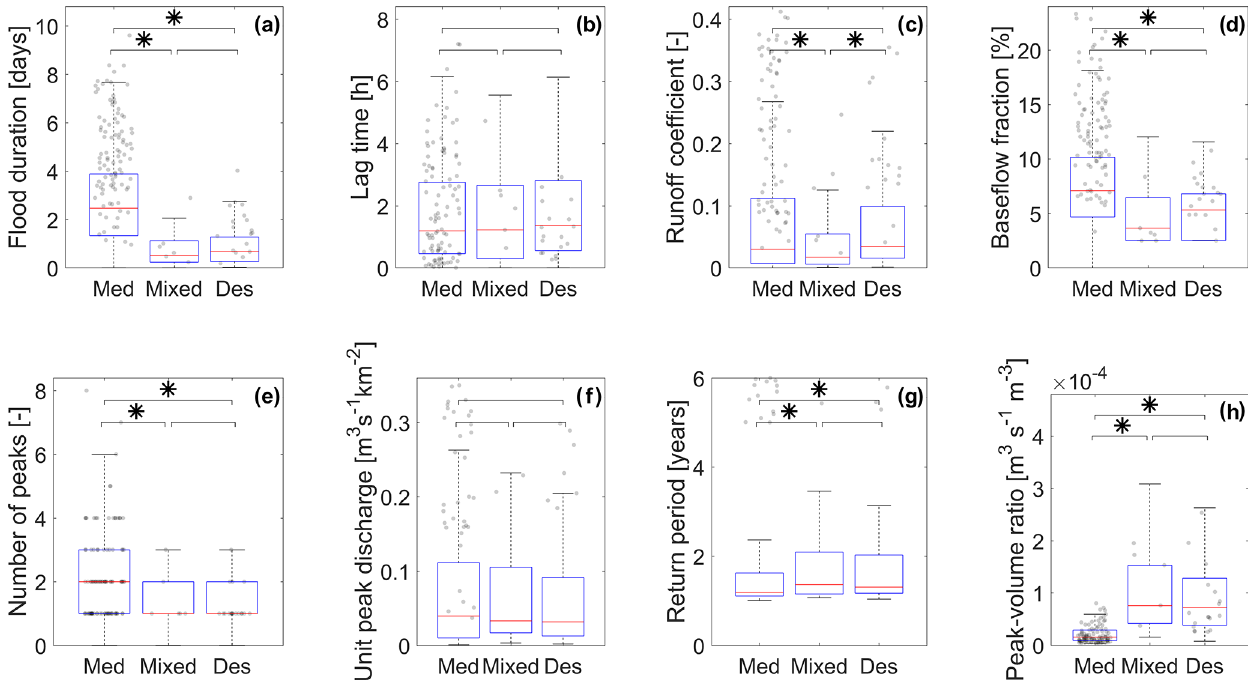
Figure 5. Boxplots showing the distribution of event runoff properties in the three climate classes. The asterisk describes distributions with a different median (Wilcoxon test, p value < 0 . 05). Black dots represent floods with more than 5 years of return period; outliers are not presented.